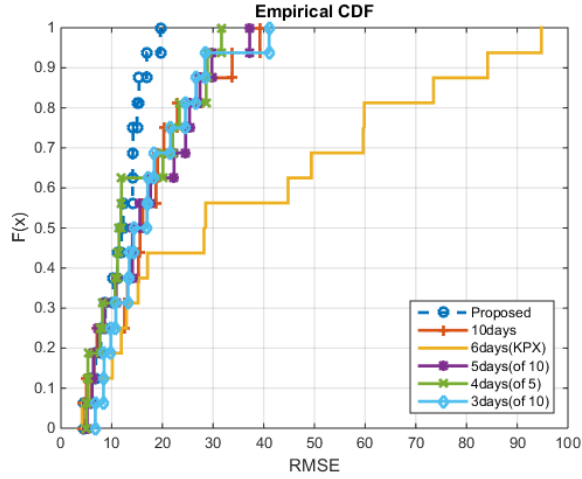
Figure 16. CDF evaluation of the proposed models in site